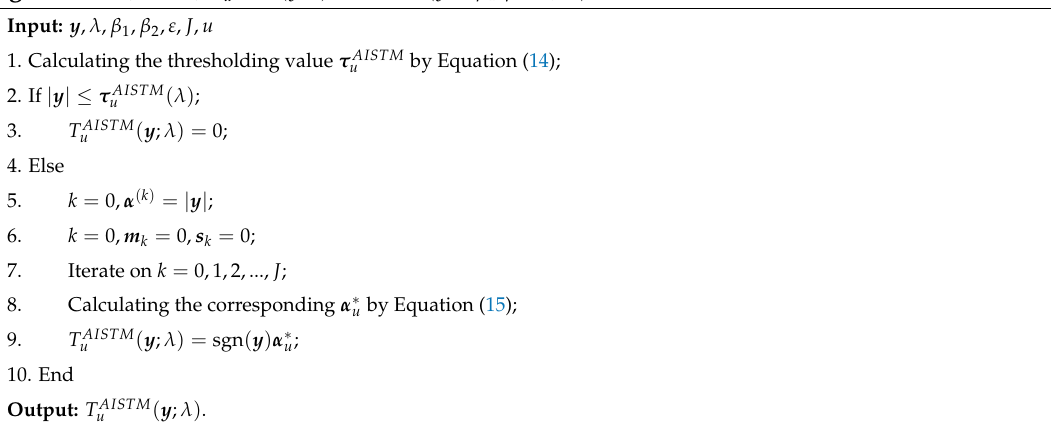
Algorithm 1 (AISTM): T AISTM